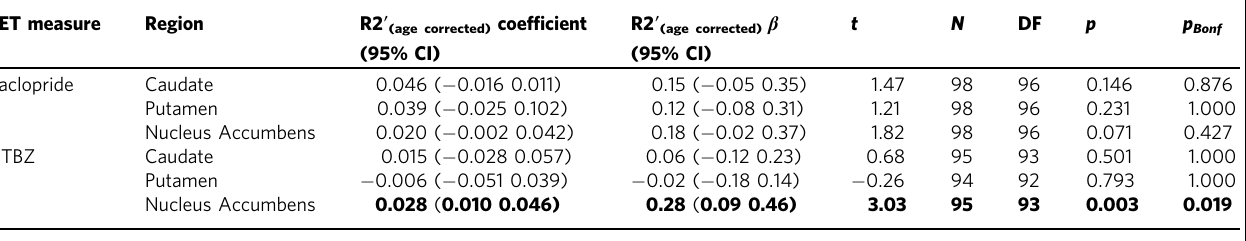
Table 3 Linear regression table for associations between R2 ′ and PET binding potentials after residualizing with respect to age. PET